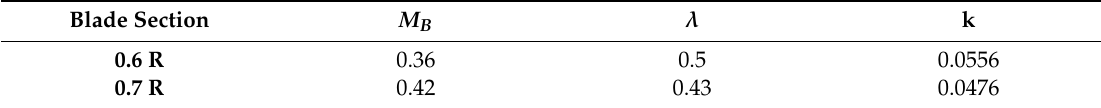
Table 1. Airflow information at different blade sections.